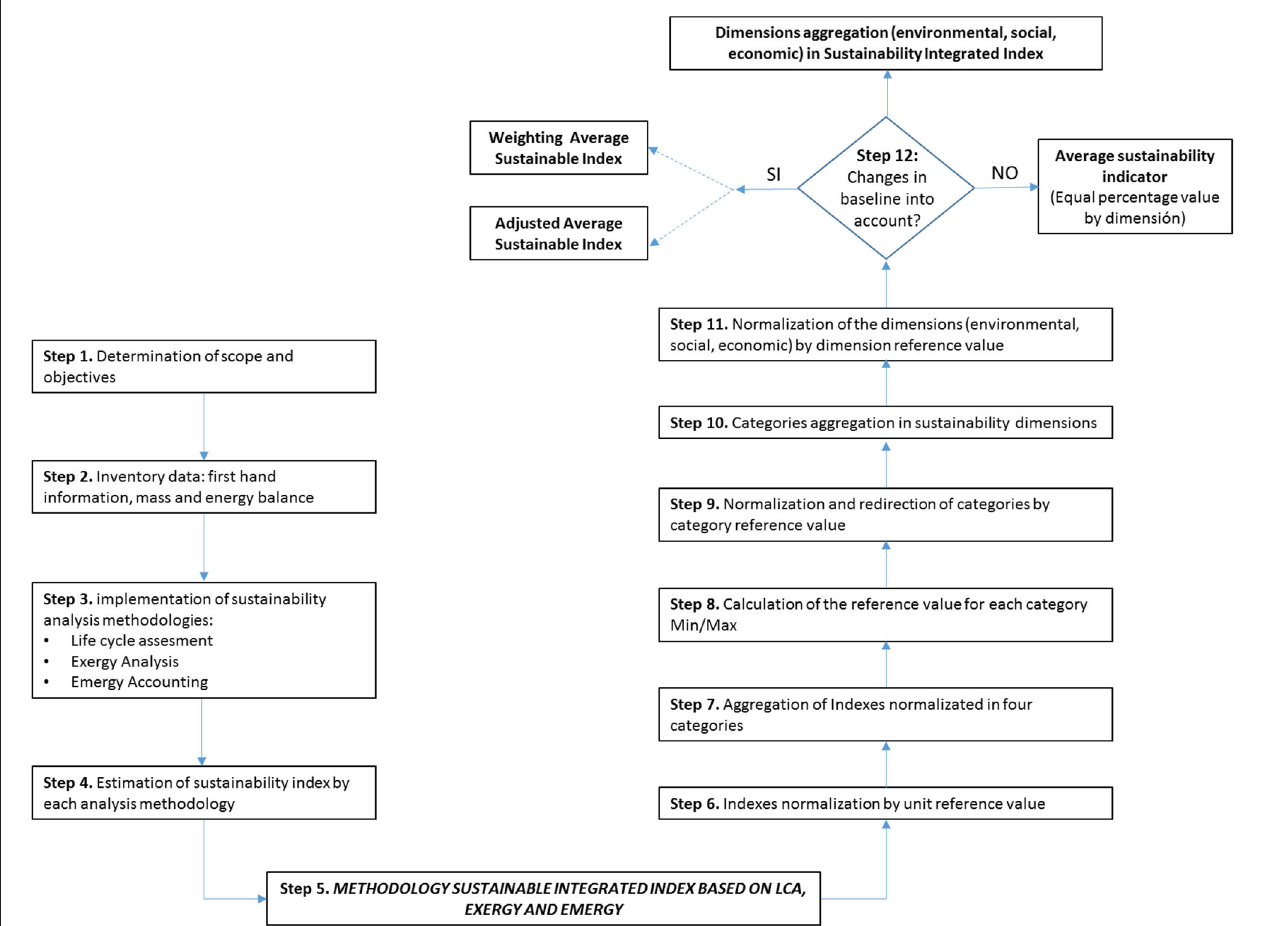
FIGURE 3 | Integrated Sustainability Index (ISI) methodology